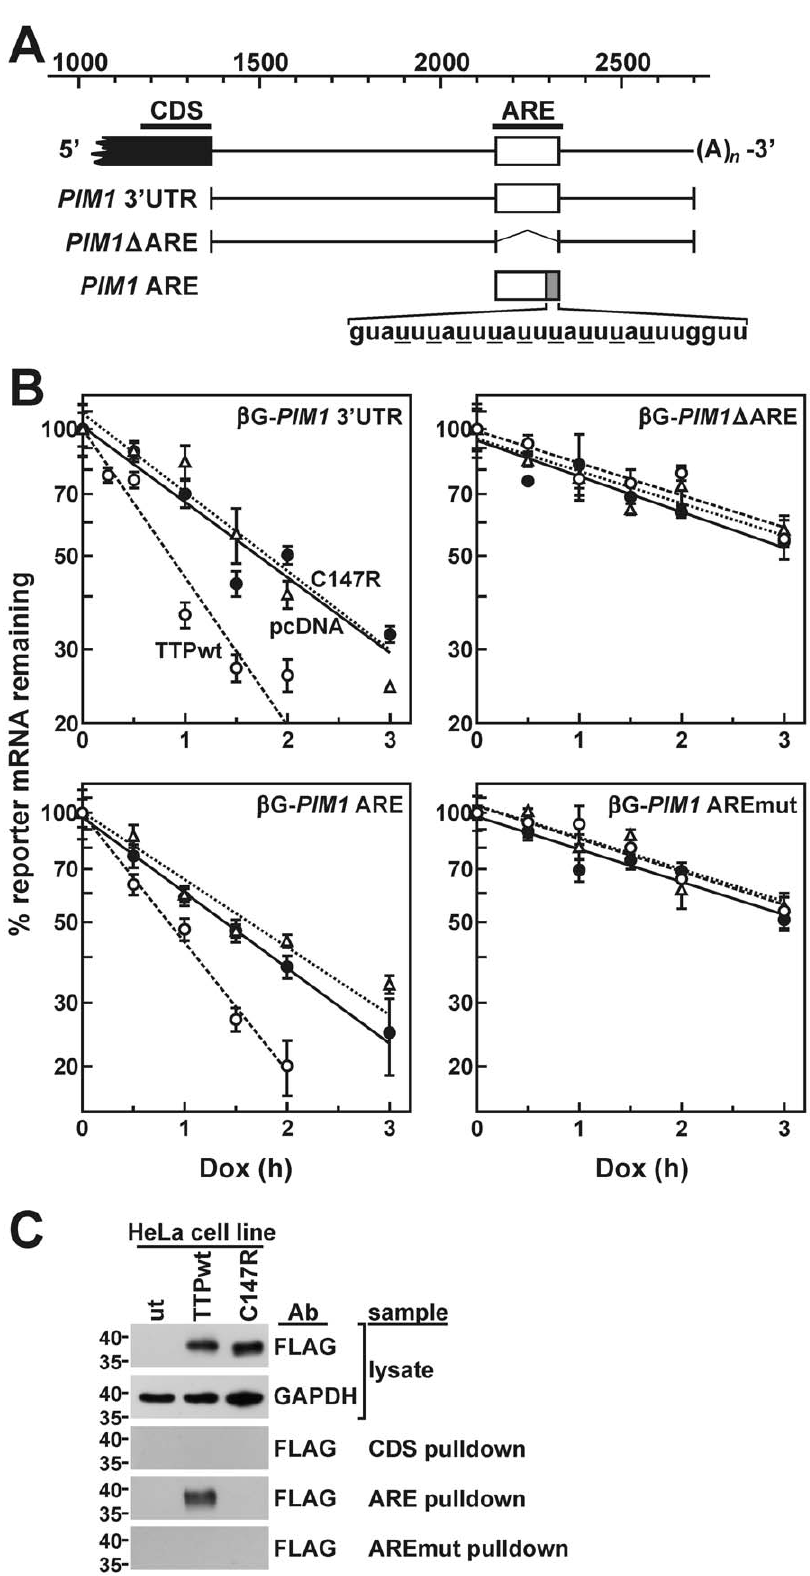
Figure 5. Localization of TTP-responsive elements to an ARE-like sequence in the PIM1 mRNA 3 9 UTR. (A) Schematic of the 3 9 -end of the PIM1 mRNA coding sequence ( black box ) and complete 3 9 UTR, including the ARE domain ( white box ). The scale bar (top) is relative to the translational initiation codon. The positions of biotin-labeled riboprobes corresponding to the PIM1 ARE and coding sequence fragment (CDS) are shown as black bars above the mRNA schematic. Bars below delineate PIM1 3 9 UTR domains that were subcloned downstream of the translational termination codon